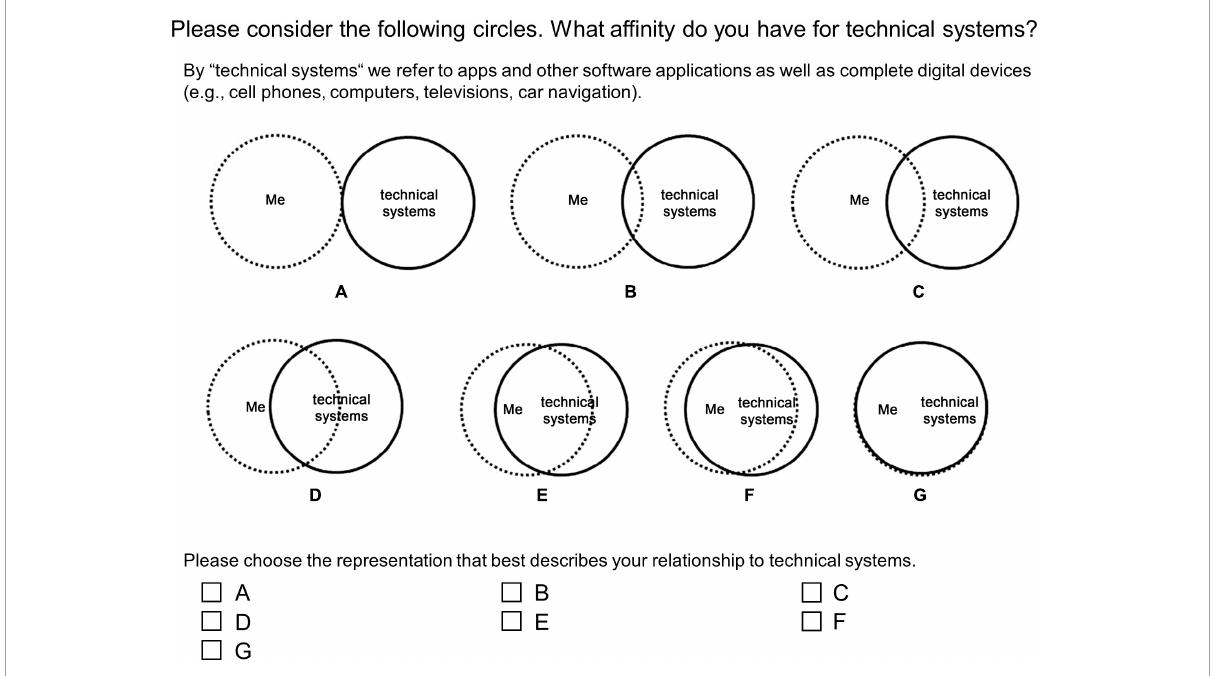
FIGURE2 The newly developed instrument for measuring technology affinity: Inclusion of Technology Affinity in Self scale